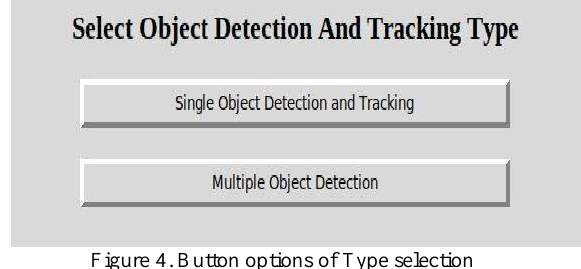
Figure 4. Button options of Type selection